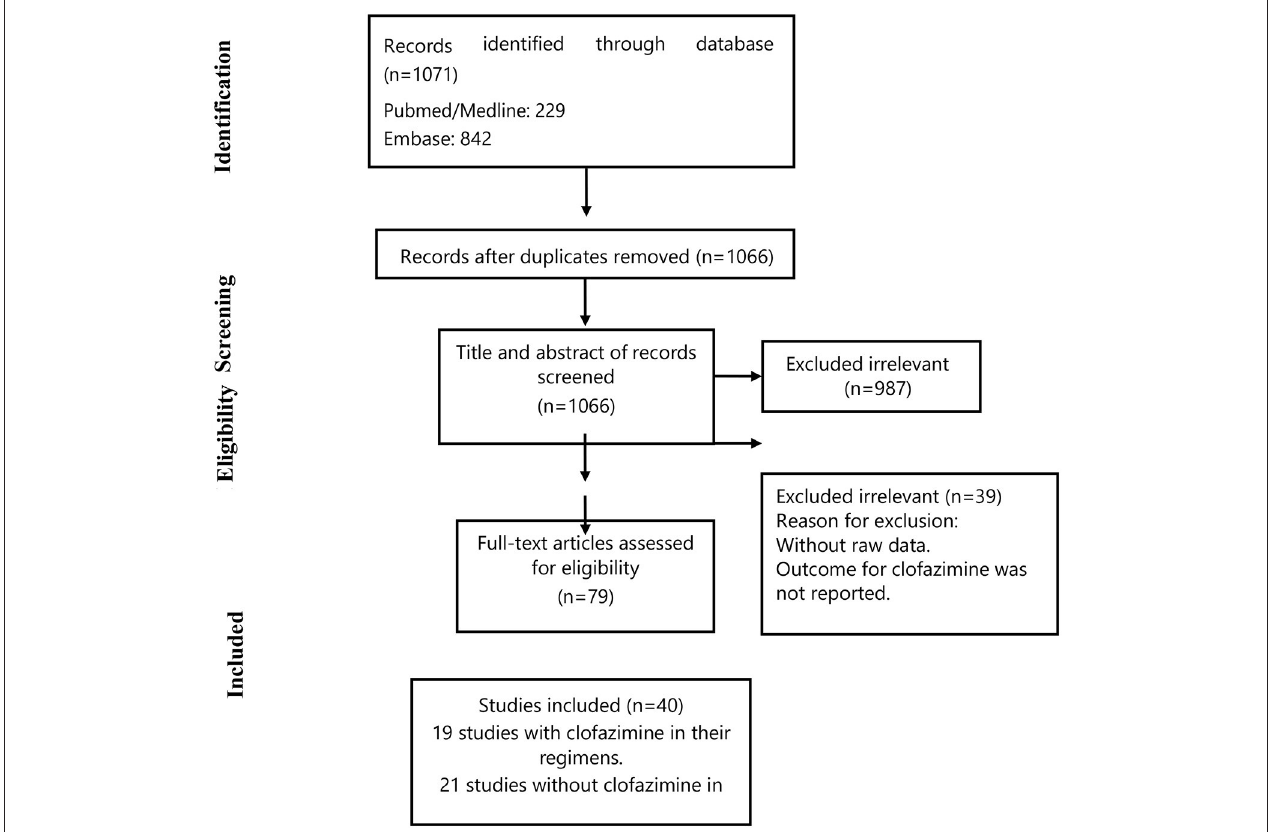
FIGURE 1 | Flow chart of study selection for inclusion in the systematic review and